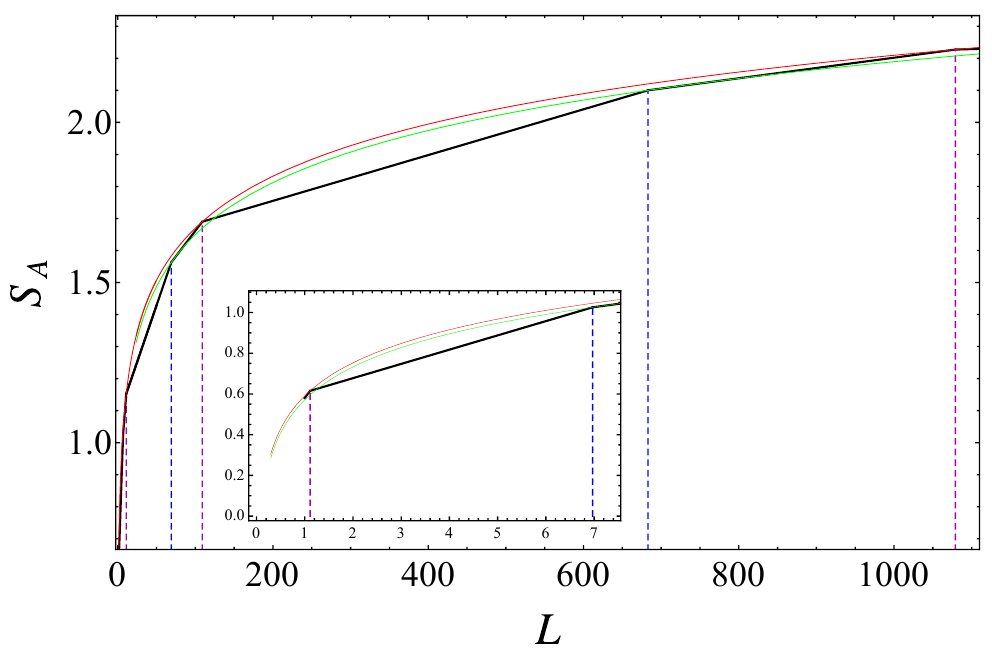
Figure 9: Entanglement entropy of a block of L consecutive sites in an aperiodic XXX chain with modulation induced by the inflation rule σ { . The black solid curve is 6,5 } obtained from (57), while the coloured ones correspond to the logarithmic envelopes (cid:39) 0.576 (green) and κ (cid:39) 0.591 (red). Both curves have a coefficient in (58) with κ 1 2 of the logarithm given by (61) with q = 5. The vertical dashed lines correspond to the breaking points of the black curve occurring at L = Λ (blue lines) and L = Λ 2 k − 1 2 k (purple lines) given in (42) and (43),